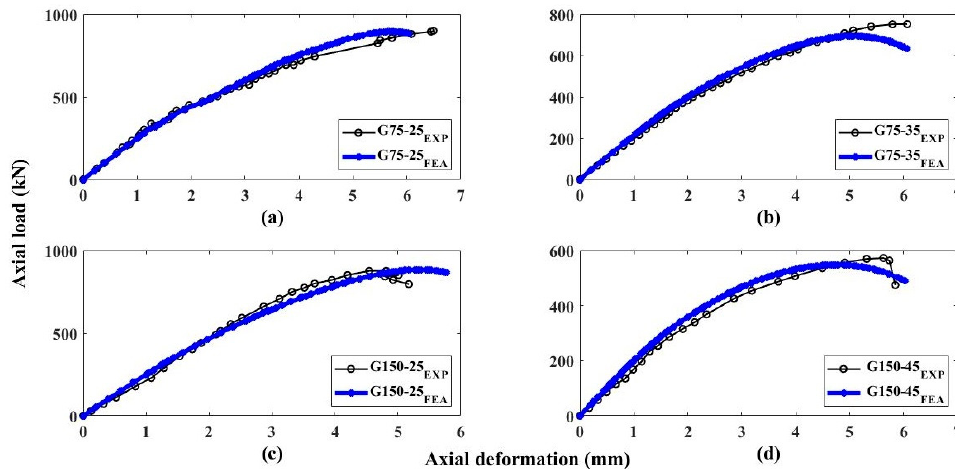
Figure 12. Load-deflection performance of GFRP-RC eccentric columns ( a ) G75-25 ( b ) G75-35 ( c ) G150-25 ( d )